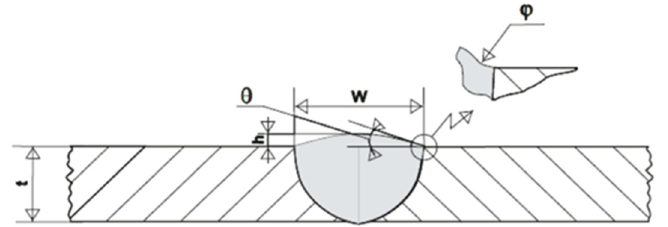
Figure 1. Influential geometric quantities of the butt-welded joint [8]. Table 4. Experimental results.